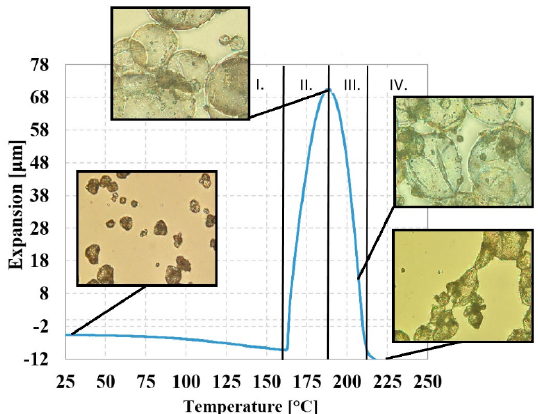
Figure 4. Analysis of the expansion of blowing agent Tracel G 6800 as a function of temperature, measured by Thermomechanical analysis (TMA), supported by optical microscopy pictures.